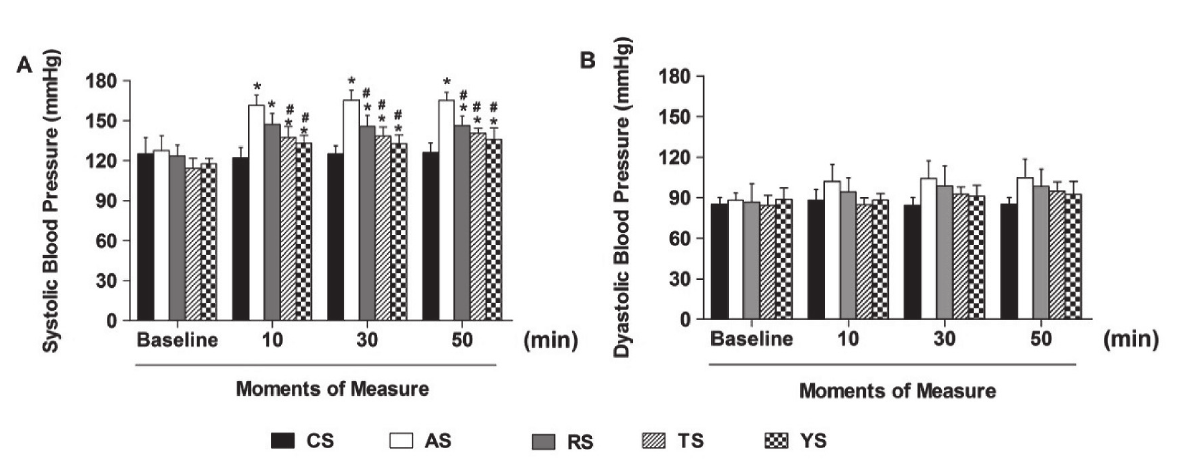
Figure 2 - It shows the values of systolic (Panel A) and diastolic (Panel B) blood pressure during the sessions. Note:*statistical difference between the time of measurement of heart rate during exercise, and their resting values. #Difference between the values during exercise compared to aerobic exercise. Signi fi cant difference with value of p < 0.05.